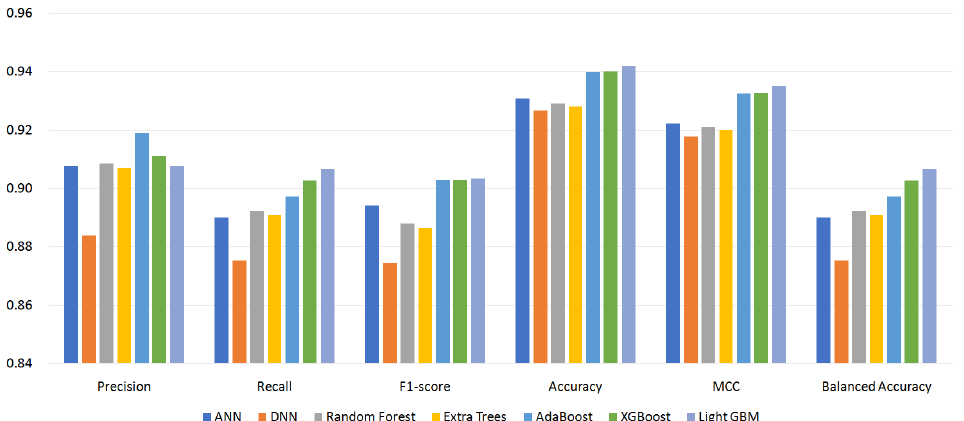
Figure 5. Performance of classifiers with permission set